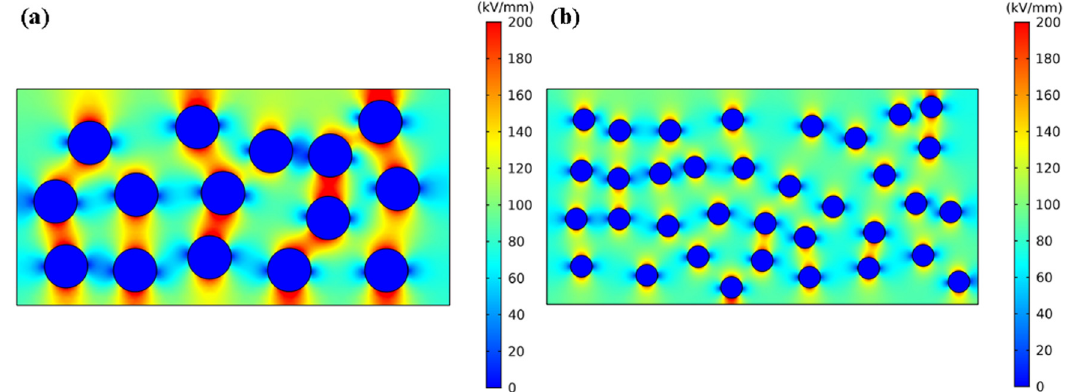
Figure 6: Finite element simulation diagrams for Electric fi eld distribution of the LDPE composite loaded with ( a ) 10vol% CCTO and ( b ) 10vol% CCTZO